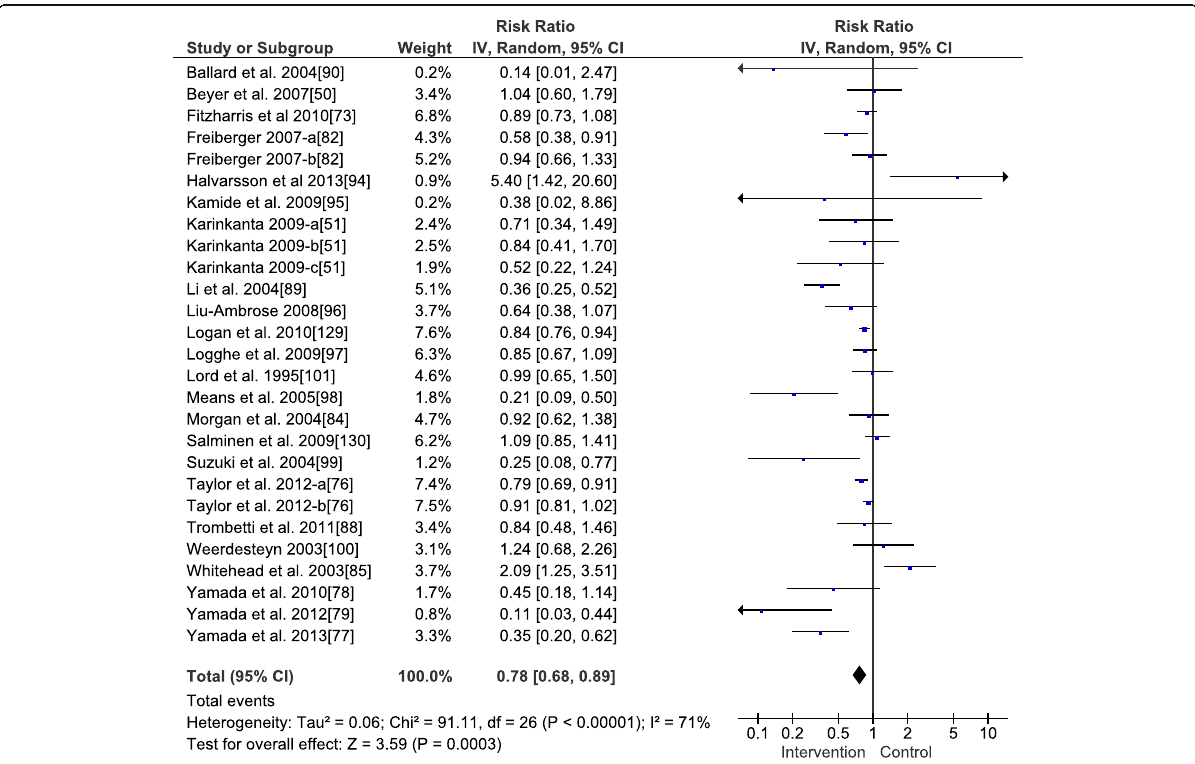
Fig. 3 Forest plot for the meta-analysis of the fall risk ( n = 3927). An inverse variance (IV) analysis was performed and the 95% confidence interval (CI) is provided. The studies followed by the letters a or b or c mean that they include different intervention groups, and each letter resembles one intervention